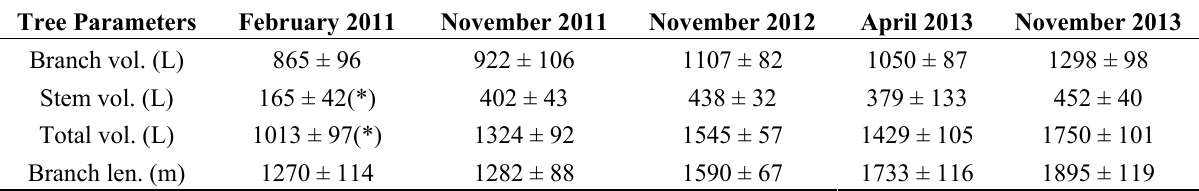
Table 5. Espoonlahti maple: Tree branch and stem parameters. The branch length is the sum of the lengths of cylinders not classified as stem.